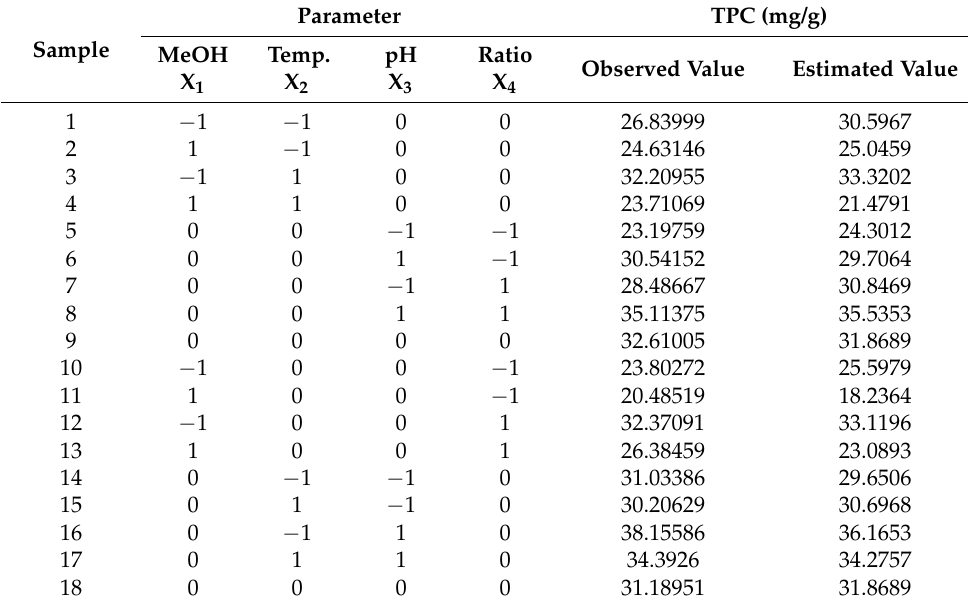
Table 1. Microwave-assisted extraction (MAE) of the total phenolic compounds in Santolina chamaecy- parissus according to a Box-Behnken